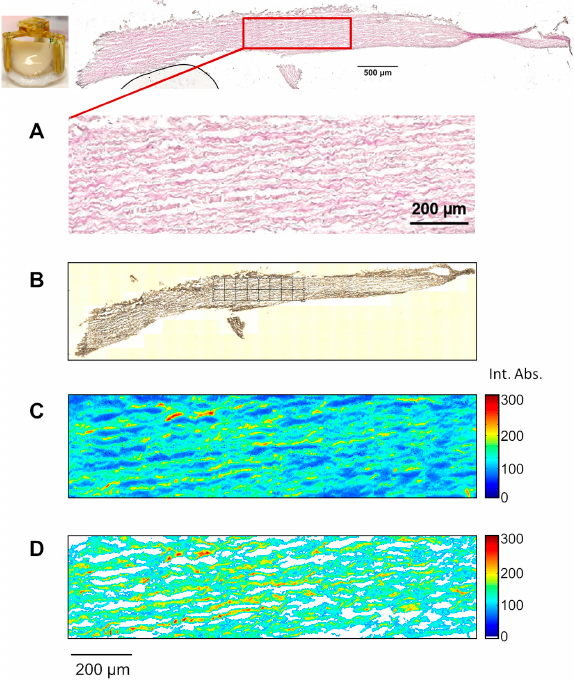
Figure 6. Von Kossa / HE staining of a non-implanted bioprosthesis sample with region analysed in FT-IR imaging. ( A ) bioprosthesis sample and resulting histological von Kossa / HE staining (entire section in the upper panel). ( B ) region analysed by IR spectroscopic imaging ( C ) IR spectroscopic image (brightfield image) and ( D ) IR spectroscopic image after preprocessing. White pixels indicate outliers.